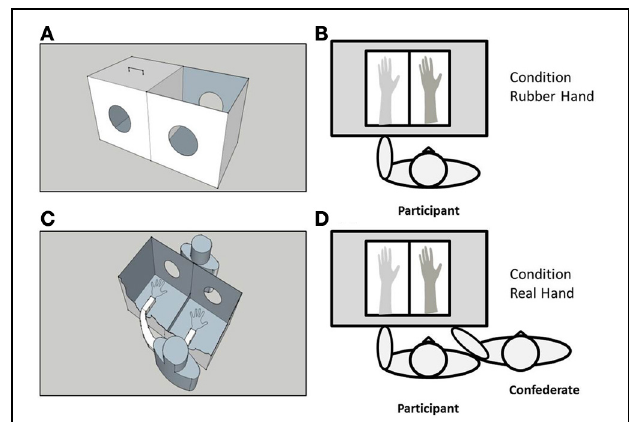
FIGURE 1 | A schematic representation of the experimental set-up. A black wooden box measuring 34 × 65 × 44cm (A) was placed approximately 15cm in front of the participant’s torso, with the center of the box in alignment with the participant’s left shoulder (B) . The box was divided into two equal parts by a perpendicularly placed piece of opaque glass. Two circular holes (14cm in diameter) on either side of the box allowed the participant and experimenter to place their arms inside; the left half of the box accommodated the participant’s left forearm and hand, and the right half the rubber (C) or confederate’s real (D) forearm and hand. A wooden lid (shown in A ) prevented visual feedback of the participant’s own arm. The top side of the box on the right was uncovered, allowing direct vision of the rubber/confederate’s forearm and hand.